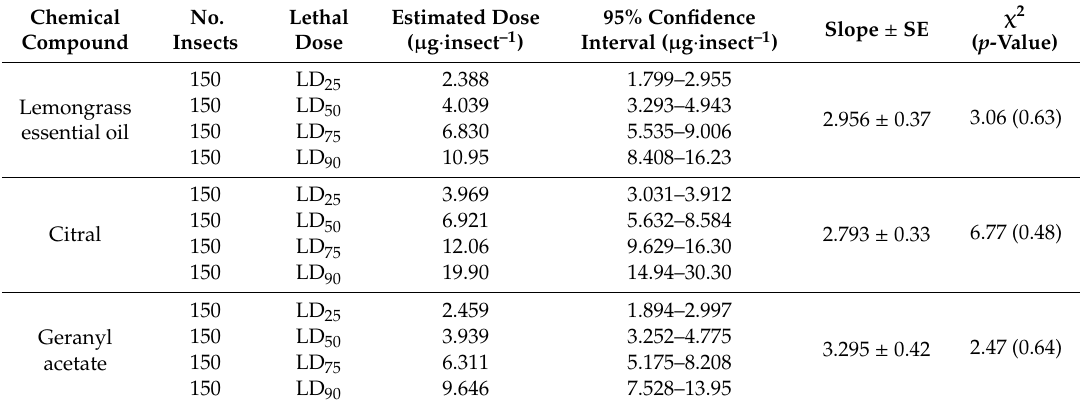
Table 2. Lethal doses of lemongrass essential oil and their components against Sitophilus granarius after 24 h of exposure, obtained from probit analysis (df = 5). The chi-square value refers to the goodness of fit test at p > 0.05.